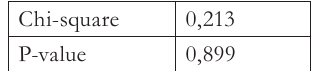
Tab. 1 - Statistical test of dependence between business size and voluntarism in business estab- lishment. Source: Authors’ calculations.